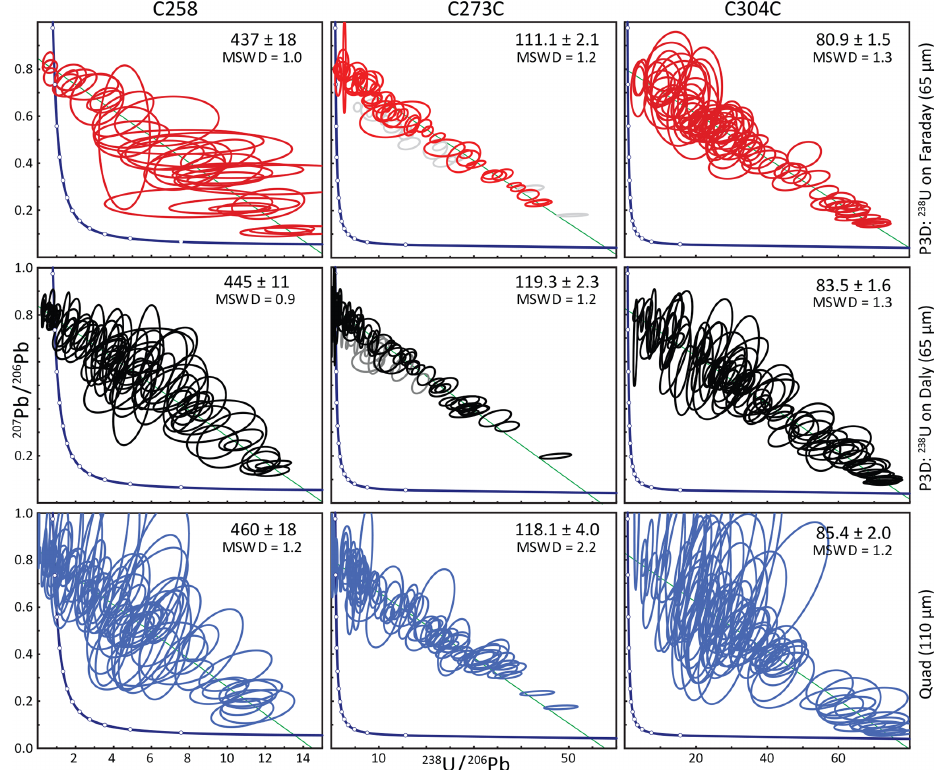
Figure 2. Tera–Wasserburg concordia diagrams of the three unknown samples in each of the three experiments. See text for